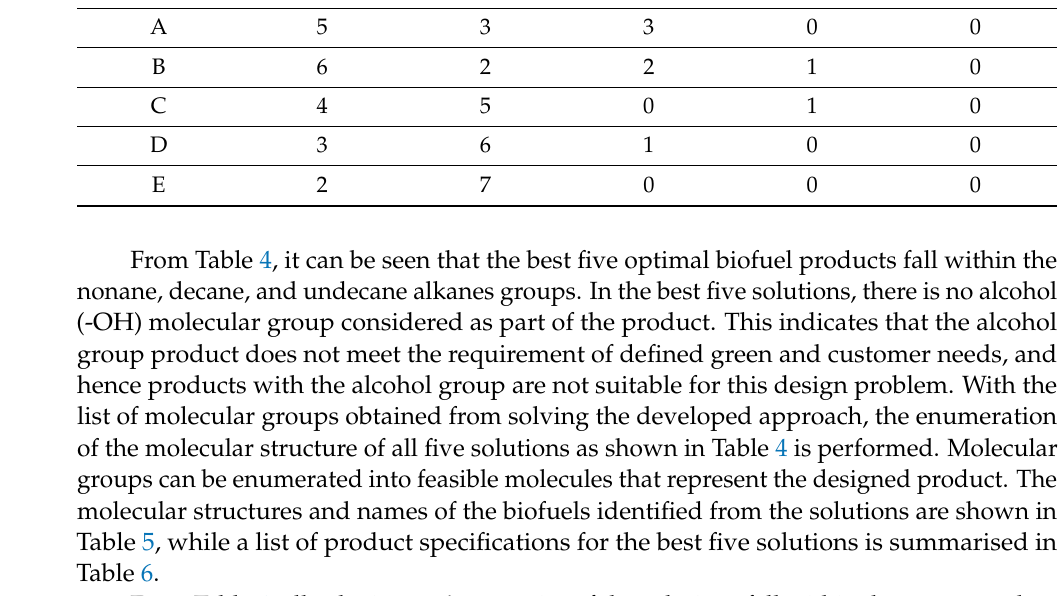
Table 5. Molecular structures of designed product.